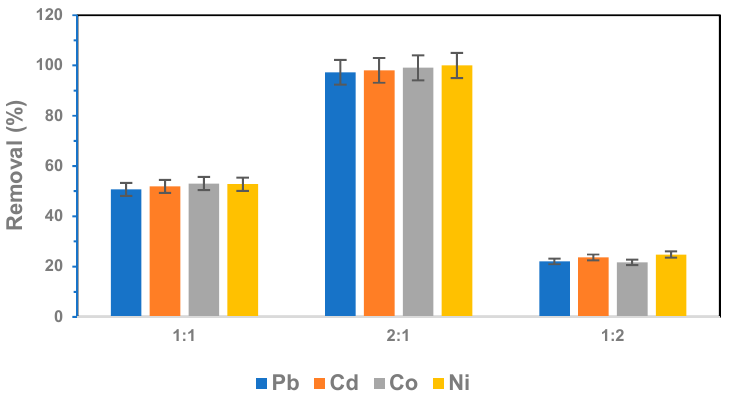
Figure 2. Comparison of adsorption performance of 1:1, 2:1, and 1:2 inulin–TEOS hybrid adsorbent with different metal ions.